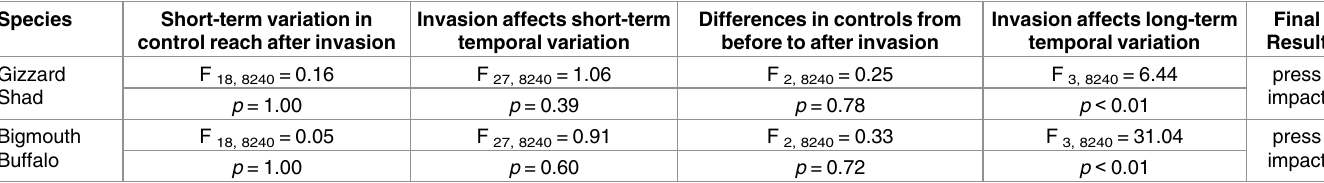
Table 2. Summaryof asymmetrical analysesof variance. Summary of asymmetrical analysesof variancecomparing catch per unit effort of Gizzard Shad and Bigmouth Buffalo from the MississippiRiver Basin from before and after Silver Carp invasion.Final results are determined from a sequenceof tests describedin [44]. Species Short-term variation in Invasion affects short-term Differences in controls from Invasion affects long-term control reach after invasion temporal variation before to after invasion temporal variation Gizzard